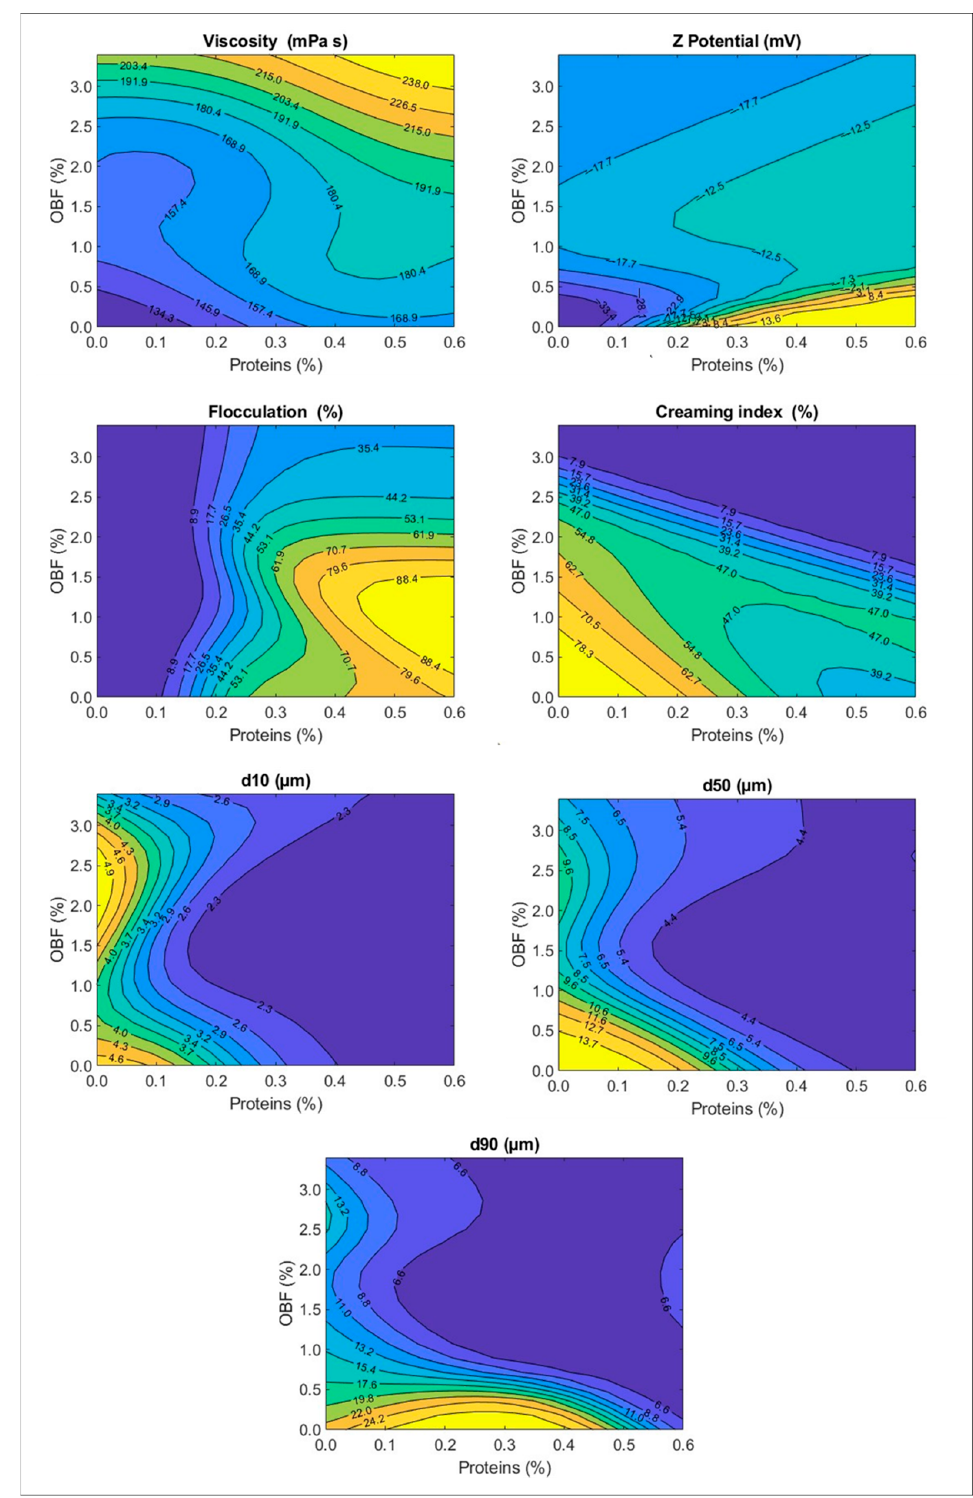
Figure 5. Contour plot of each emulsion characteristic predicted by ANNs at different levels on a protein-content–OBF content